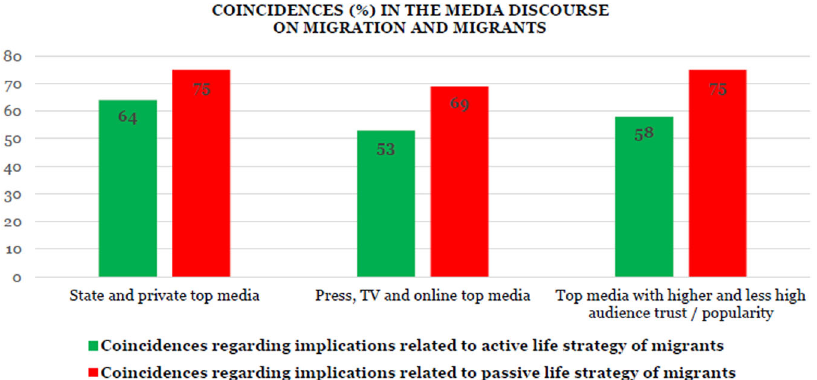
Fig. 5 Coincidence of presence or absence of implications related to life strategies of migrants in different types of Ukrainian top media (2015 – 2018, sample from every February messages). Source: A. Tashchenko ’ s elaboration based on qualitative content analysis (by L. Yuzva and A. Tashchenko), analysis of discourse positions and sociocognitive critical discourse analysis (by A. Tashchenko) of media messages. Data source: The Center for Content Analysis research based on quantitative media content analysis, 2019. The comparative bar chart illustrates the proportions of media discourse similarity between media with different discourse positions: green bars show in what percentage of cases the presence or absence of implications about an active life strategy coincided; red bars show in what percentage of cases the presence or absence of implications about a passive life strategy